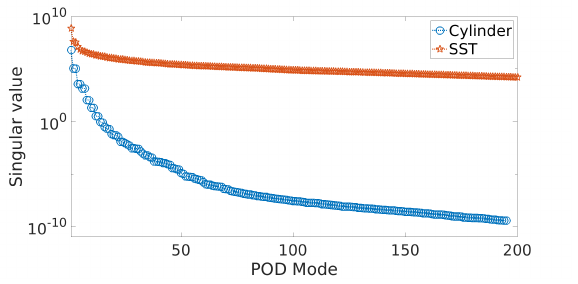
Figure 5. Singular value spectrum of the data matrix for both the cylinder wake flow at Re = 100 and the sea surface temperature(SST) data.